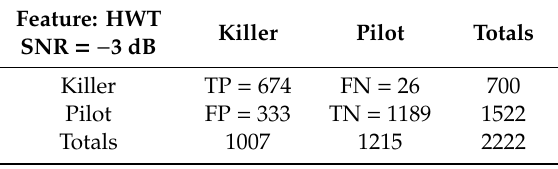
Table 11. Classification results: HWT, SNR = − 3 dB.